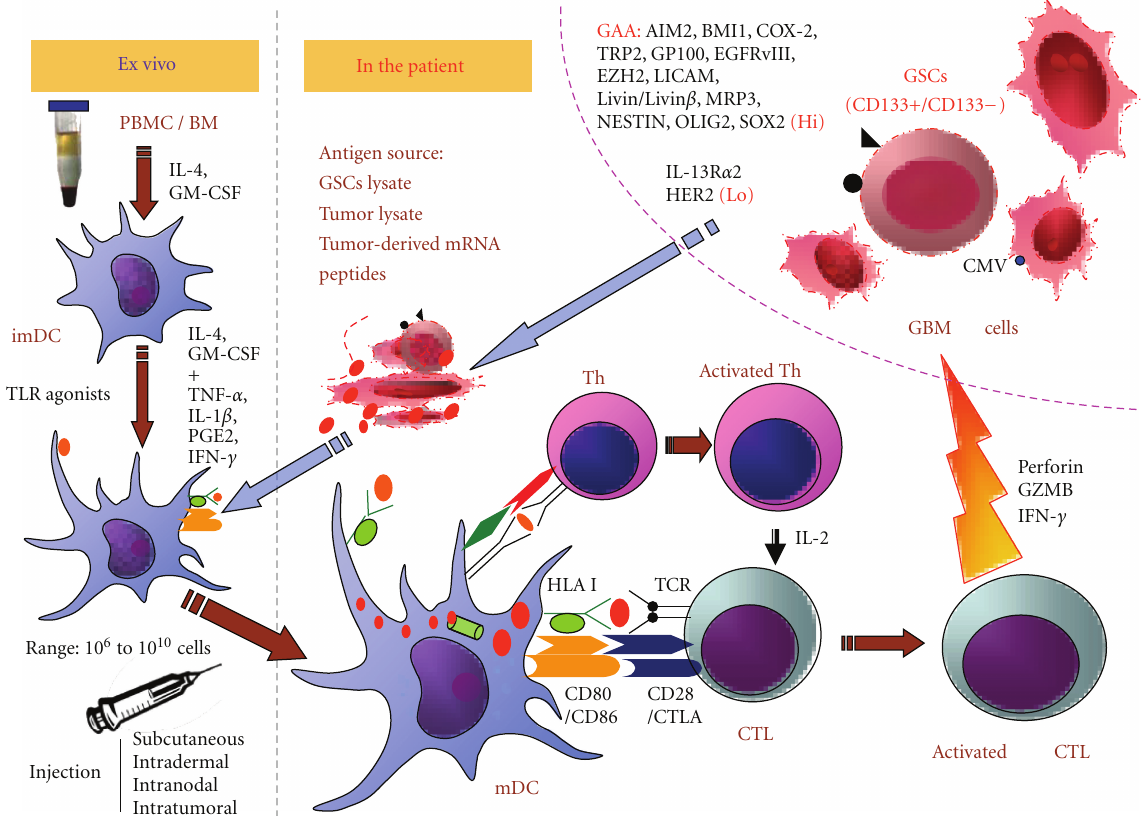
Figure 1: DC-based active immunotherapy for GBM. DCs display a unique capacity to induce and to maintain T-cell responses. Mature DCs are generated from PBMC in vitro in the presence of IL-4, GM-CSF, TNF-alpha, IL-1beta, PGE2, IFN-gamma, and other cytokines, in addition to TLR agonists. Subsequently, they are loaded with GBM or glioblastoma stem cell lysates, GBM-associated antigen-derived peptides, protein, or RNA. Due to their high surface expression of HLA-peptide-complexes and costimulatory molecules, DCs could e ffi ciently activate and expand CD8 + CTLs and CD4 + Th cells. CD8 + CTLs are able to recognize and eliminate tumor cells, especially the GBM stem cells (CD133). CD4 + Th cells enhance the capacity of DCs to induce CTLs by the interaction between CD40 on DCs and CD40 ligand on activated CD4 + T cells. In addition, CD4 + T cells help in the maintenance and expansion of CTLs by secreting IL-2. CTLs: cytotoxic T cells; imDC: immature dendritic cells; GZMB: granzyme B; GSCs: glioblastoma stem cells, HLA: human leukocyte antigen; IL: interleukin; IFN: interferon; mDC: mature dendritic cells; PBMC: peripheral blood mononuclear cells; TCR: T-cell receptor; Th: T helper cell; TLR: toll-like